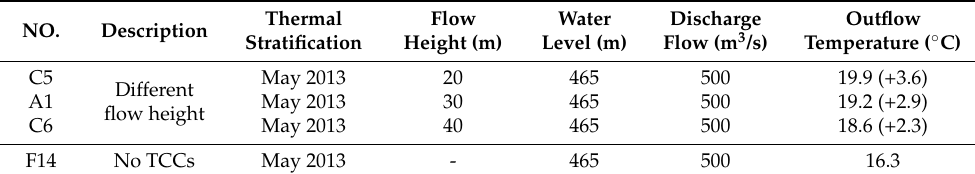
Table 6. Different flow height test scenarios and results.